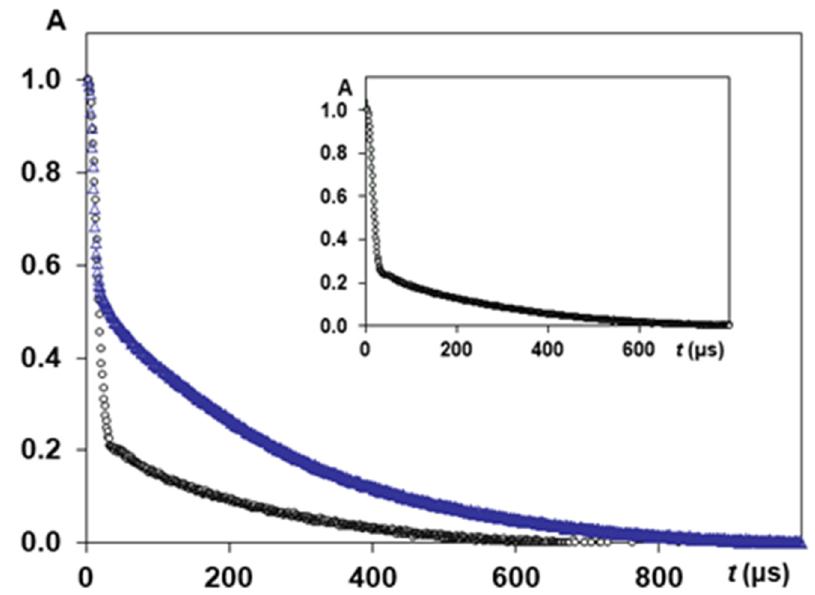
Figure 5. The typical FIDs measured on the silk fibres B. mori with perpendicular orientation to static magnetic field B 0 ; black circles (lower curve): data for dried fibres with low HL = 0.084; blue triangles: FID data for wet fibres with HL = 0.54. The data were normalised per maximum signal in each experiment on dry/wet samples. A–Intensity of NMR signal. (Inset): FID data for the silk fibres B. mori after tensile loading (89 g) in water environment. NMR experiment was carried out with the perpendicular orientation of stretched silk threads to static magnetic field B 0 at HL = 0.084 and at room temperature. The solid line on the Inset picture is the fitting of experimental FID data to the sum of exponential function and Gaussian-sin c expression: f(t) = P 1. exp[ − a 2. t 2 /2] . [sin(b . t)/b . t], where 1/ a = T 2g – spin-spin relaxation time for fast-relaxing protons.